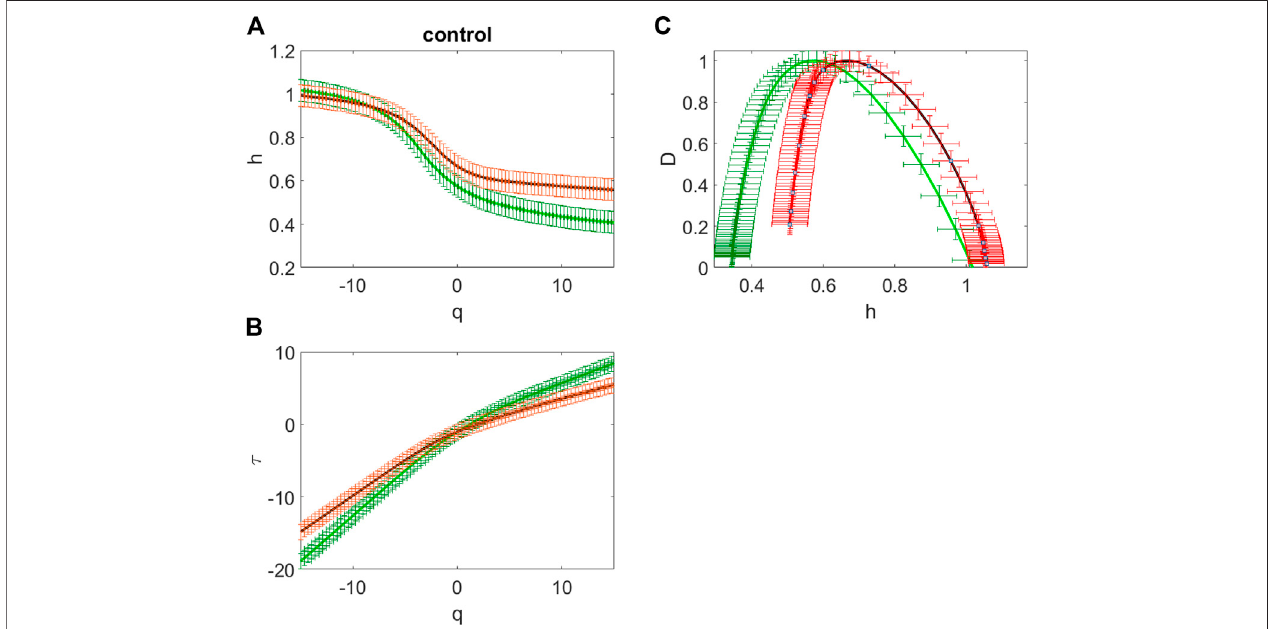
FIGURE 3 | The averaged dependences h ( q ) of the Hölder exponent on the power q value (A) , the averaged scaling exponents τ ( q ) (B) and the averaged singularity spectra (C) for the sites over the frontal regions (F3, Fz, F4) (green curves) and over the central (C3, C4), occipital (O1 and O2), parietal (P3, P4 and Pz) and temporal (T5 and T6) regions (red curves) for the subject from the control group.